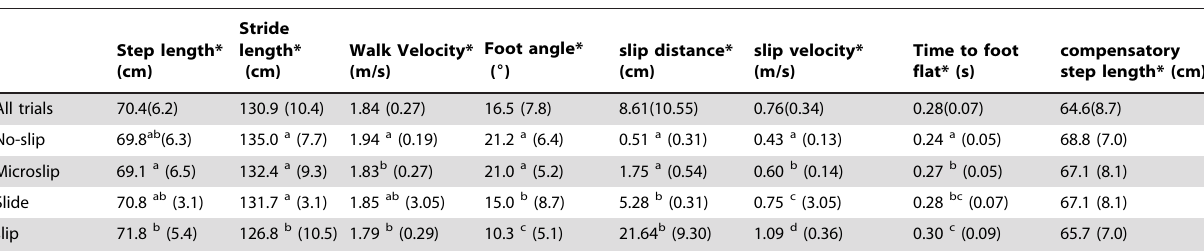
Table 4. Tempo-spatial variables in different slip